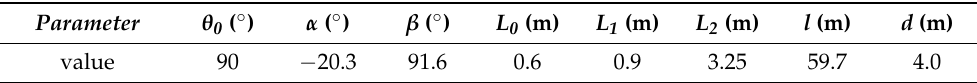
Table 1. The specific values of the optimized key parameter variables in the design of tri-reflector compact antenna test range